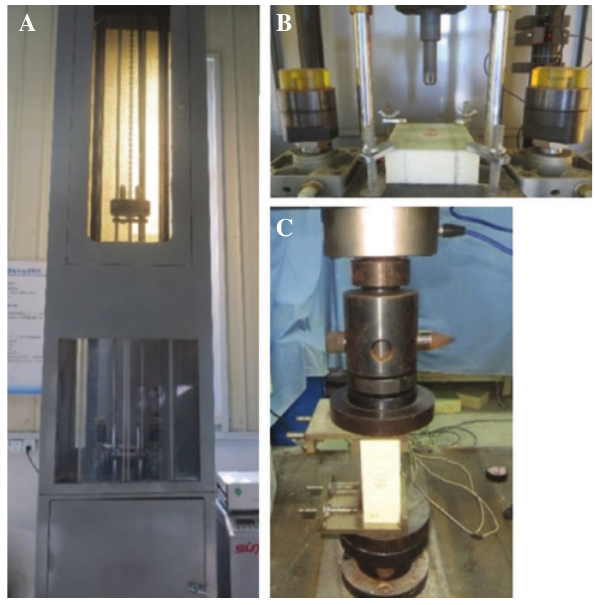
Figure 13: Test set-up for LVI and CAI tests: (A) A drop tower, (B) the impactor, and (C) CAI test